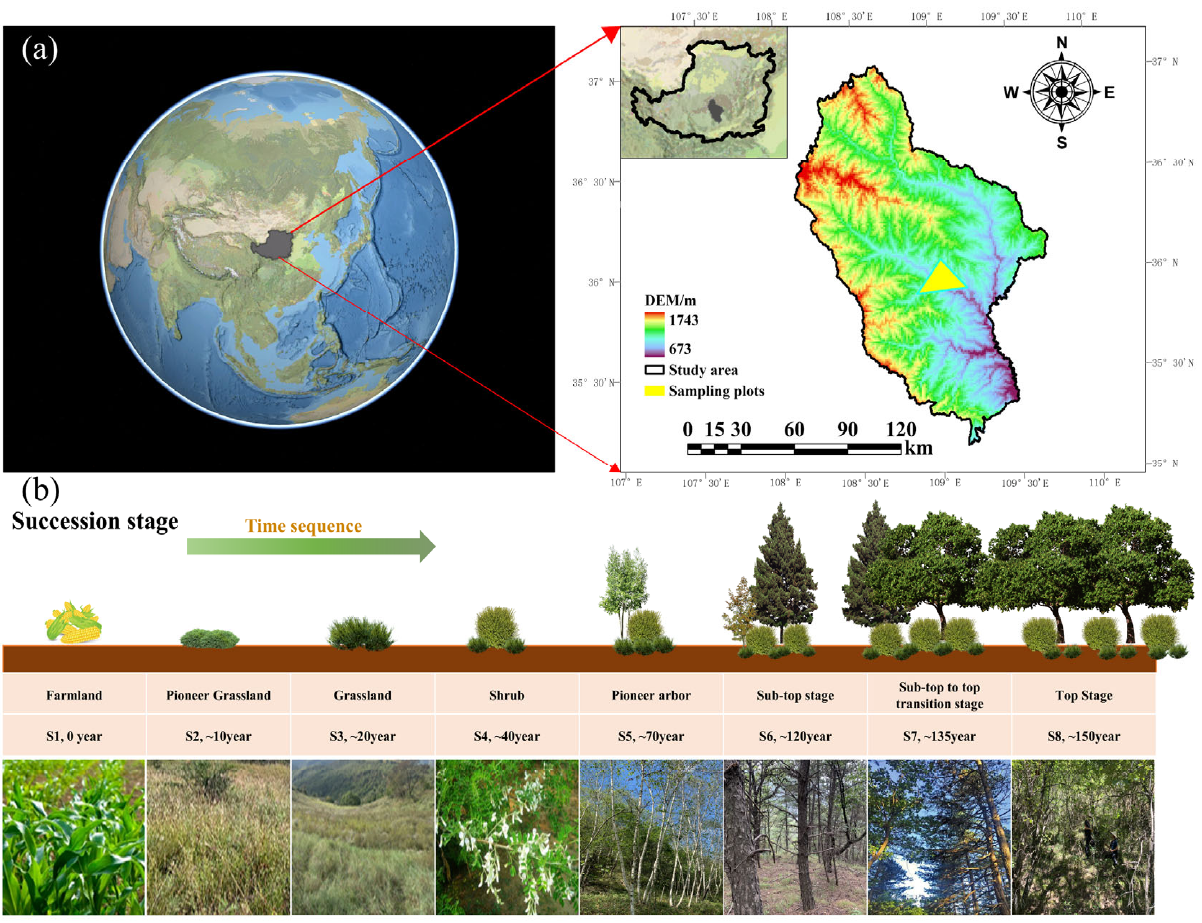
Figure 1. Different stages of vegetation restoration at the Ziwuling research site on China’s Loess Plateau. ( a ) Ziwuling research site location; ( b ) Successional sequence of vegetation restoration.